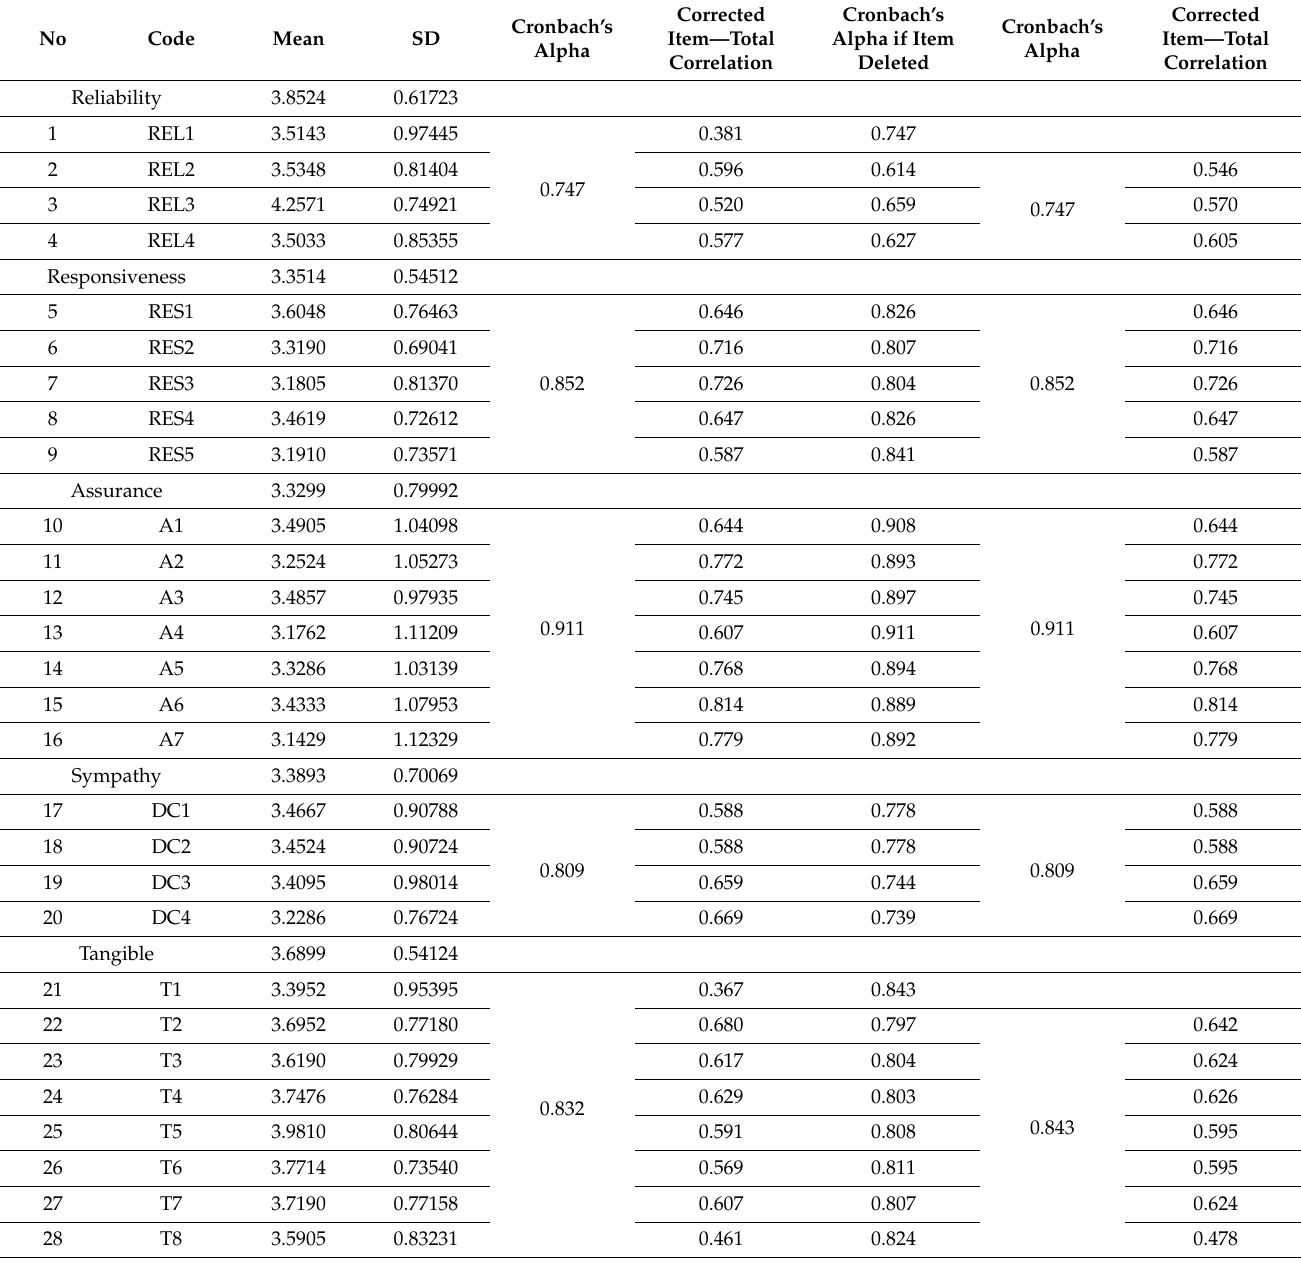
Table 3. The questionnaire’s validity and reliability analyses, considering the mean score for patient satisfaction for each domain and its